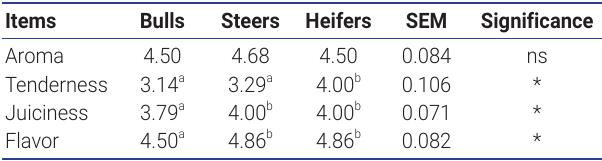
Table 5. Sensory quality of m. longissimus thoracis Items